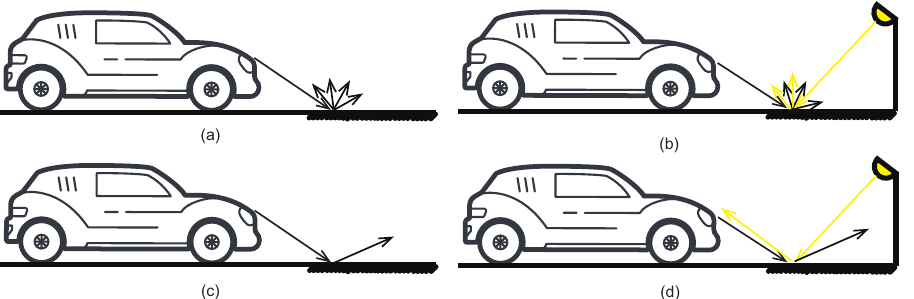
Figure 1. ( a ) Dry or snowy road conditions without ambient light illumination. ( b ) Dry or snowy road conditions with ambient light illumination. ( c ) Wet road conditions without ambient light illumination. ( d ) Wet road conditions with ambient light illumination.